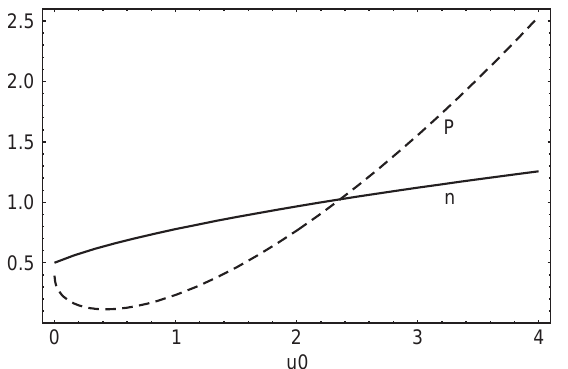
Fig. 7. Ionospheric n = N e and P = (cid:133) N e T (cid:134) as a function of the potential drop